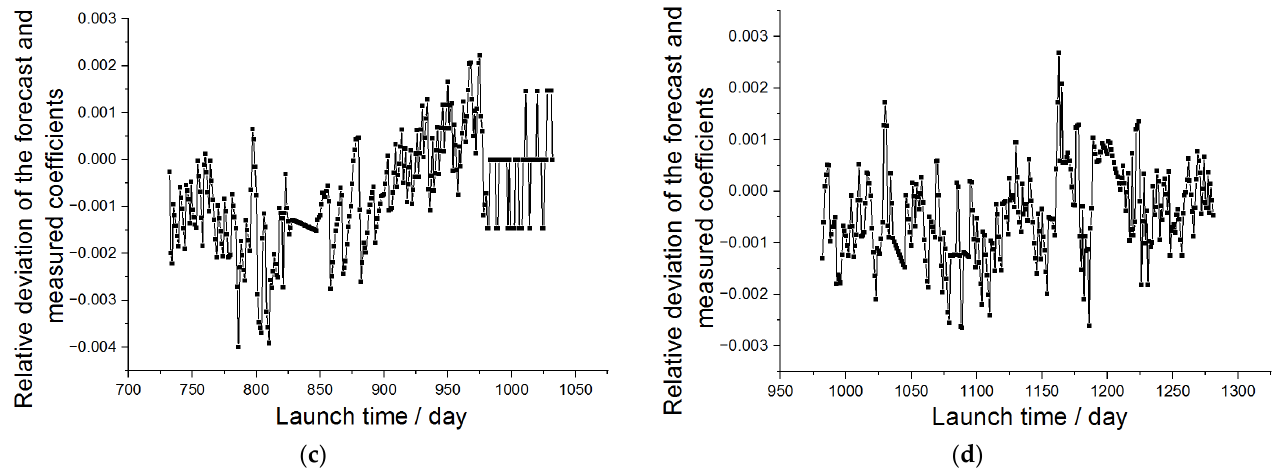
Figure 9. Calibration coefficient forecast accuracy using STL and ARIMA. ( a , b ) Comparisons of forecast data and measured data and ( c , d ) relative deviation of forecast data and measured data.